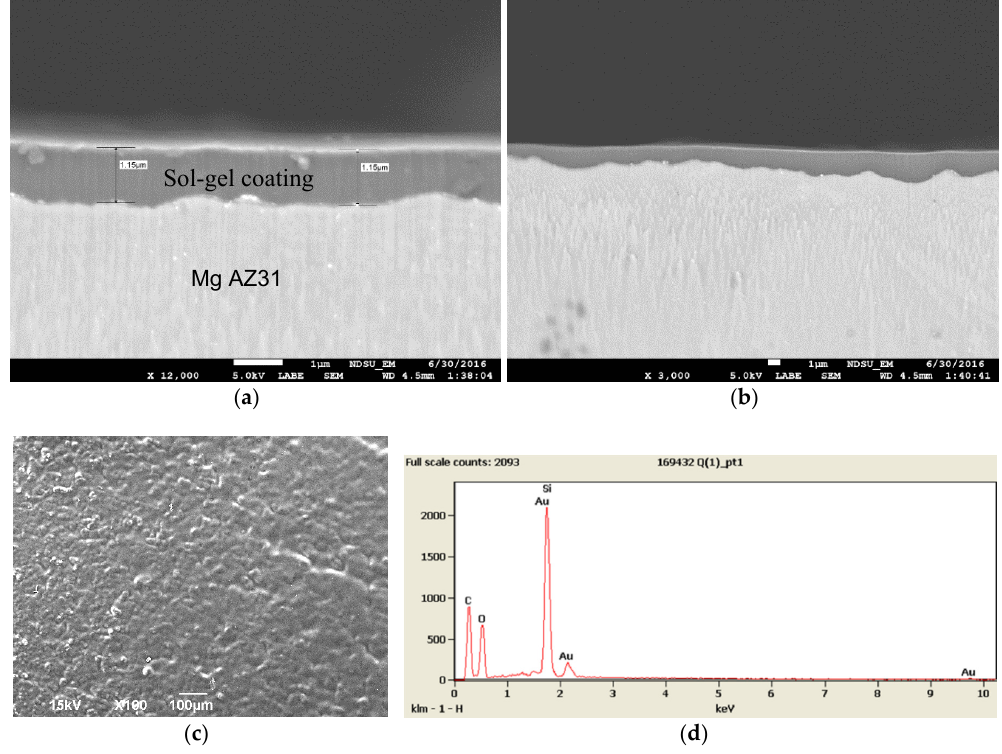
Figure 4. SEM images ( a ) of the side view at higher magnification (×12,000); ( b ) at lower magnification (×3000); ( c ) the top view; and, ( d ) the EDX elemental graph (of sol ‐ gel coating).